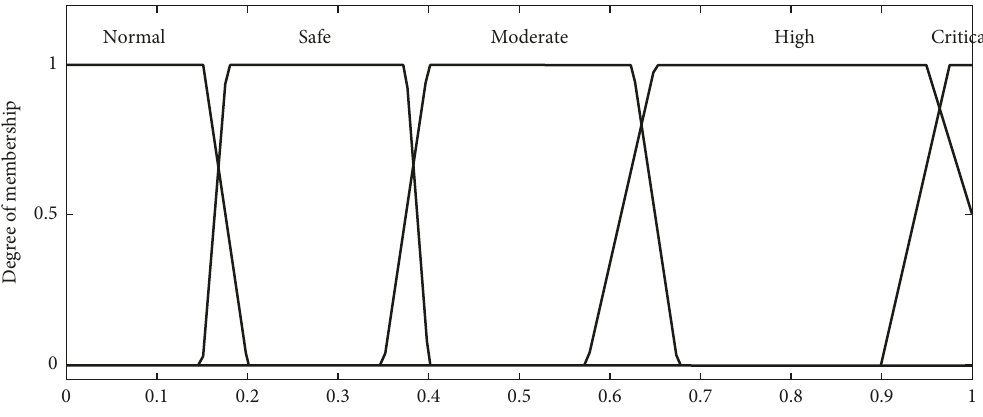
Figure 6: Output variable MF-fault